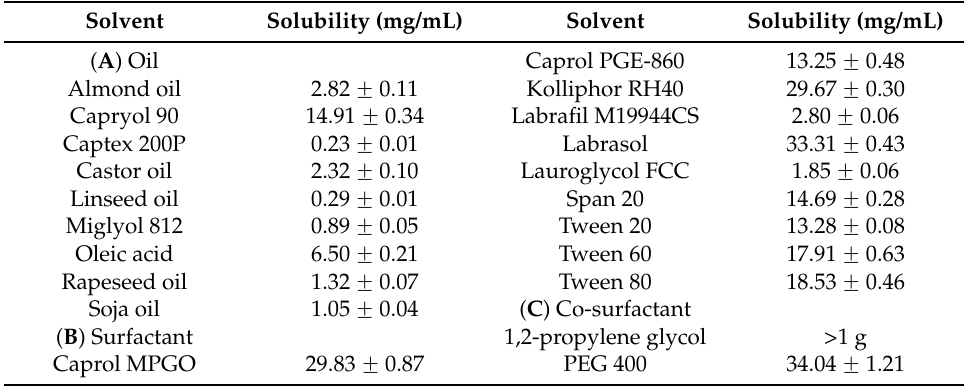
Table 1. Solubility of ATR in ( A ) oils; ( B ) surfactants and ( C ) co-surfactants.